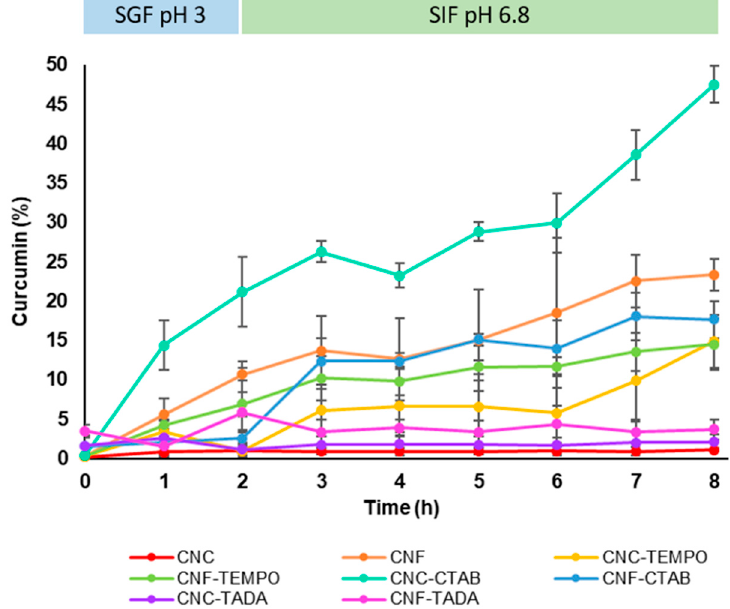
Figure 6. Curcumin release profile from modified and unmodified cellulose nanocrystals (CNC) and cellulose nanofiber (CNF) delivery systems in simulated gastric fluid (SGF, pH 3) and simulated intestinal fluid (SIF, pH 6.8). Nanocellulose modifications have been performed with cetyltrimethylammonium bromide (CTAB), tannic acid and decylamine (TADA), and by TEMPO-mediated oxidation (TEMPO).